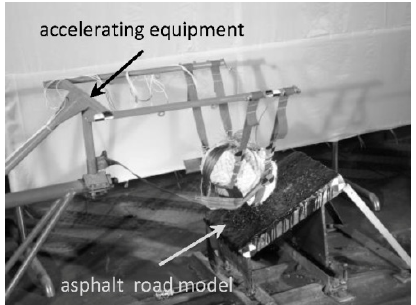
Figure 3. Head–ground impact experiment. Figure 4. Setup of head-ground impact FE model.